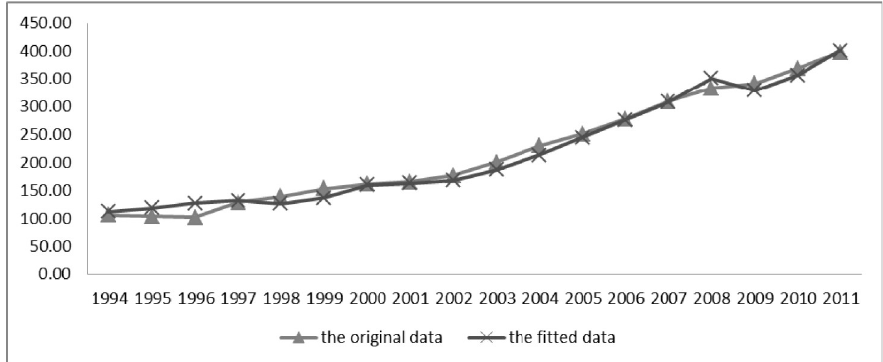
Figure 4. Fitting results of carbon emissions based on PLSR